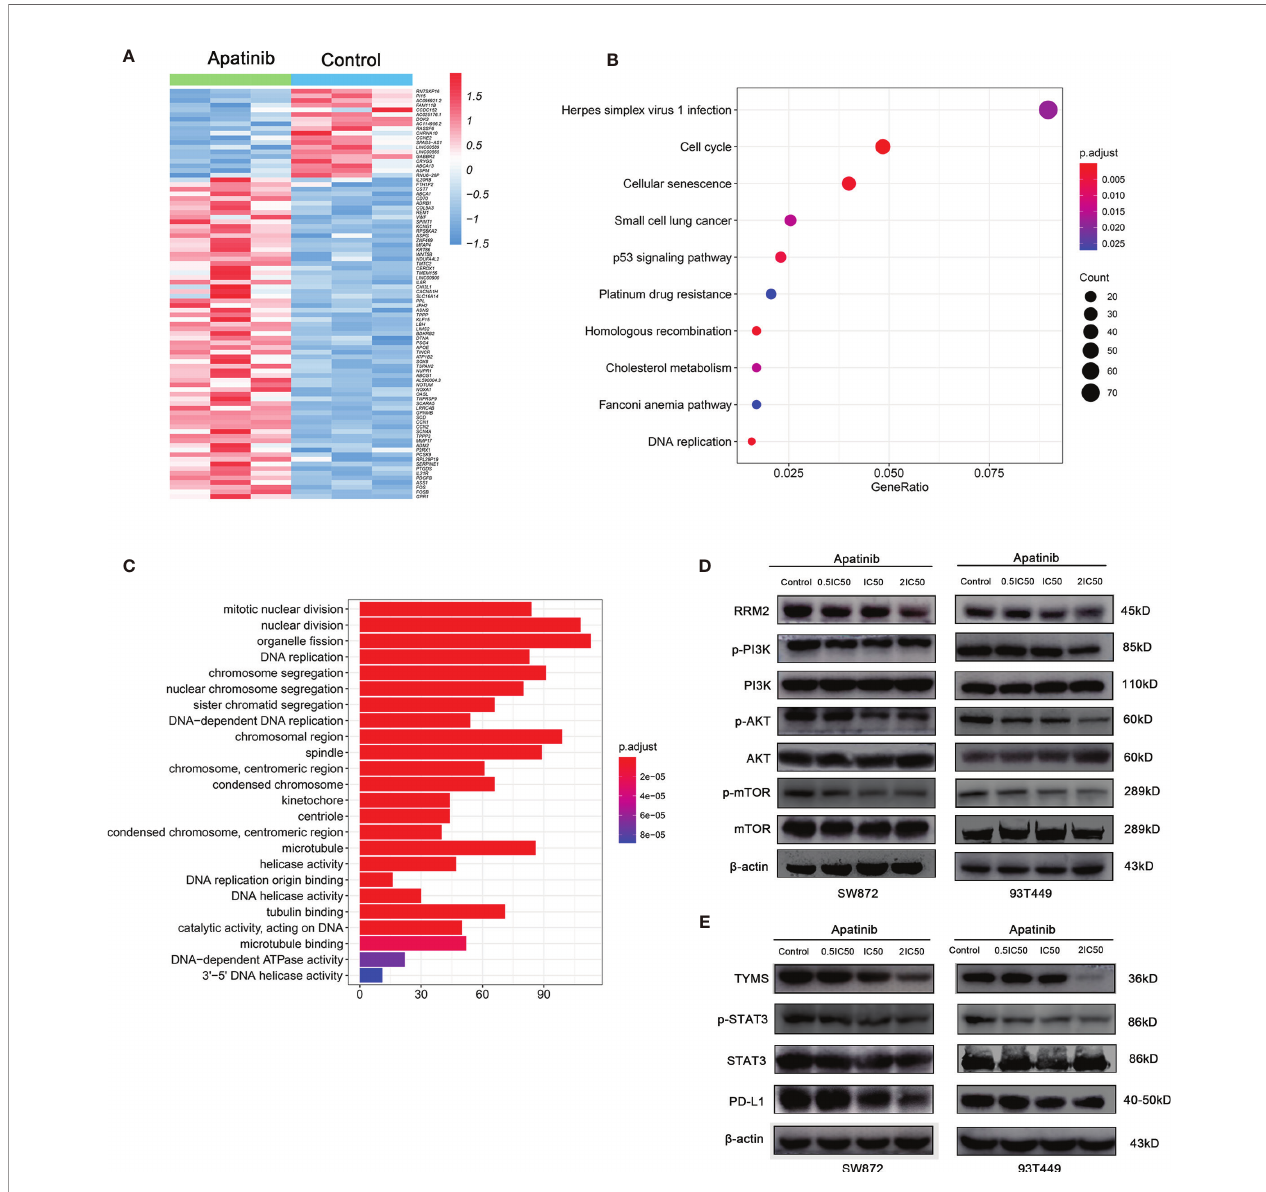
FIGURE 5 | Apatinib inhibited RRM2 and TYMS-related pathways in liposarcoma. (A) Heatmap of top representative DEGs associated with Apatinib treatment in SW872 cell lines. (B) KEGG pathway enrichment analysis indicated that Apatinib could inhibit liposarcoma proliferation through p53 signaling, DNA replication, and other important signaling pathways. (C) GO analysis showed that Apatinib application affected mainly organelle fi ssion, DNA replication, mitosis, cell cycle, and other important processes. (D) Western blotting (WB) showed that Apatinib downregulates RRM2, p-PI3K, p-AKT, and p-mTOR expression in liposarcoma cells compared with control group. (E) WB indicating that Apatinib downregulates TYMS, p-STAT3, and PD-L1expression in liposarcoma cells compared with control group.